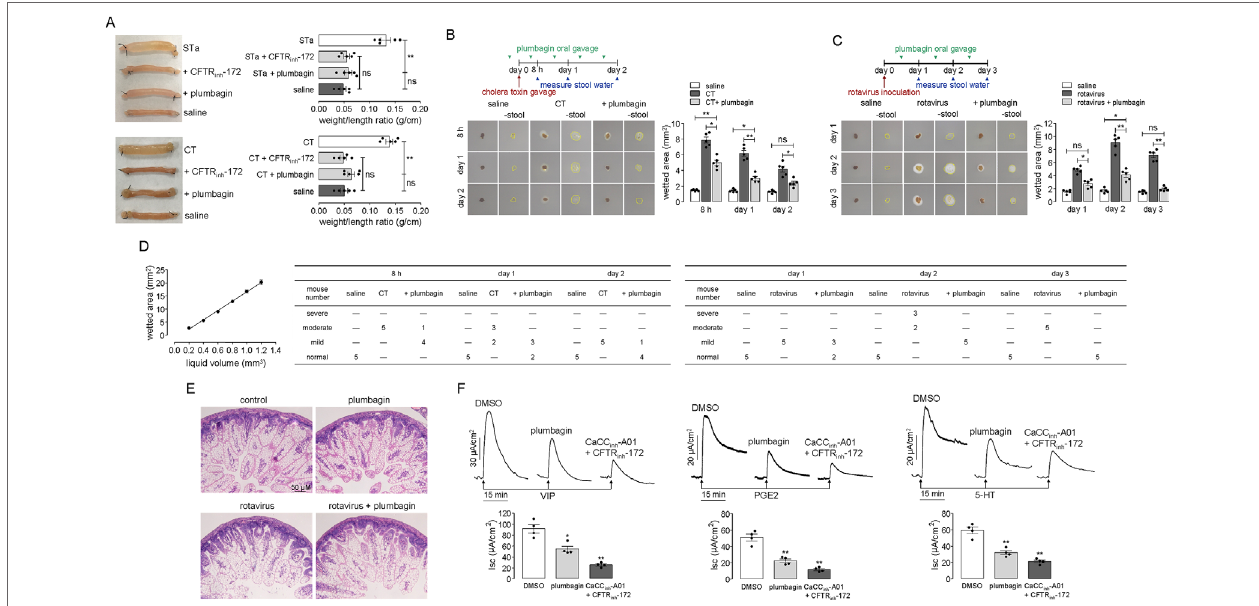
FIGURE 5 | Antidiarrheal effect of plumbagin. (A) Photographs of isolated mouse ileal loops at 3 h after injection with 100 µl saline or saline containing STa (0.1 µg) or CT (1 µg) without or with plumbagin (20 µM). The bar graph shows the ileal loop weight/length (g/cm) ratio at 3 h (5 loops per group, **p < 0.01 and ns, no significant difference). (B) Top panel: Mice were infected with CT on day 0 and were orally administered plumbagin (0.4 µg) once on the day before the CT infection and twice per day thereafter. Middle panel: The wetted area is demarcated by a dashed yellow line. Bottom panel: Summary of the wetted area at indicated times (five mice per group, *p < 0.05, **p < 0.01). (C) Top panel: Mice were inoculated with rotavirus on day 0 and were orally administered plumbagin (0.4 µg) once per day thereafter. Bottom panel: Summary of the wetted area at indicated times (five mice per group, *p < 0.05 and **p < 0.01). (D) Standard curve relating wetted area to liquid volume (n = 4) and the number of mice with moderate, severe, mild diarrhea, or normal in each group. (E) Histology of the mouse ileum on day 3 after rotavirus inoculation. Hematoxylin- and eosin-stained paraffin sections from saline-control, plumbagin, rotavirus-inoculated, and plumbagin-treated mice (scale